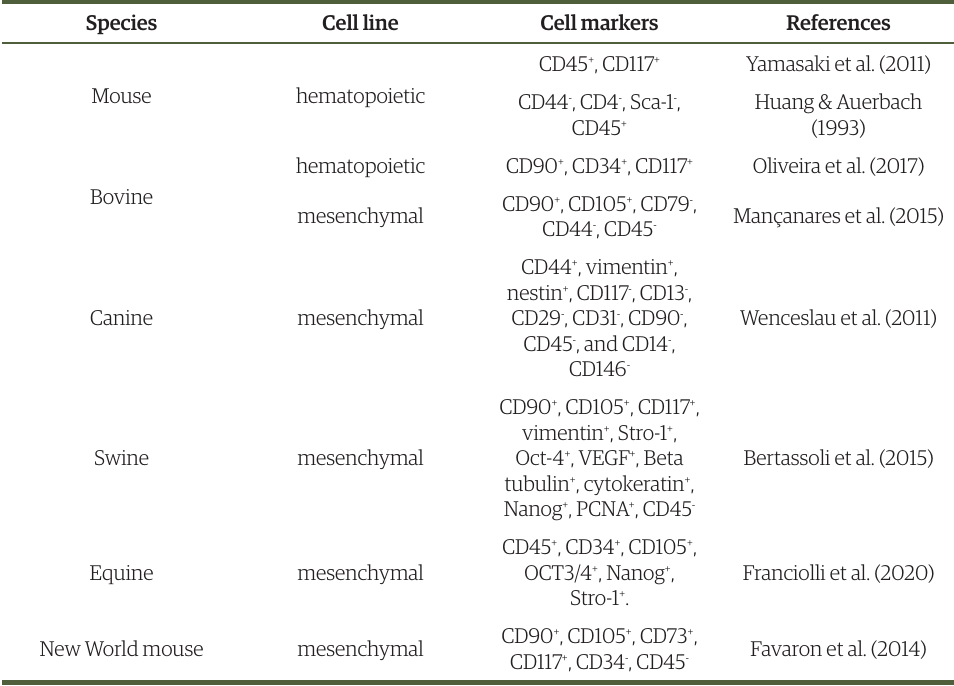
Table 1. Membrane markers of stem cells derived from the yolk sac in different species. Species Cell line Cell